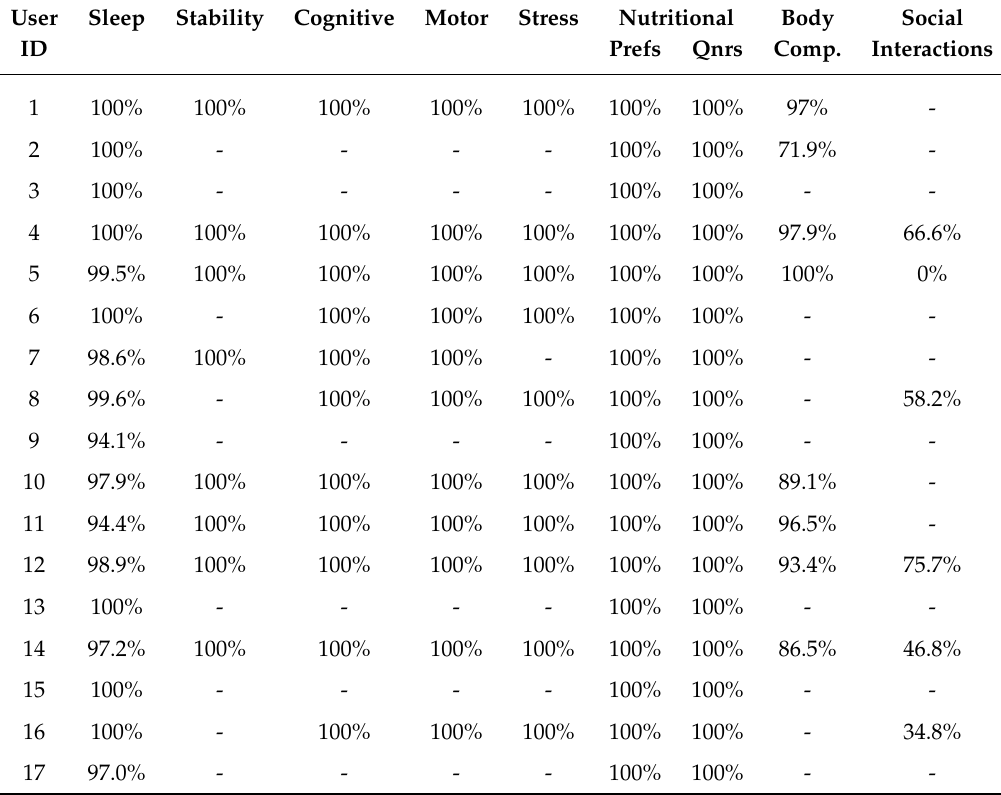
Table 4. Data validity for each service and